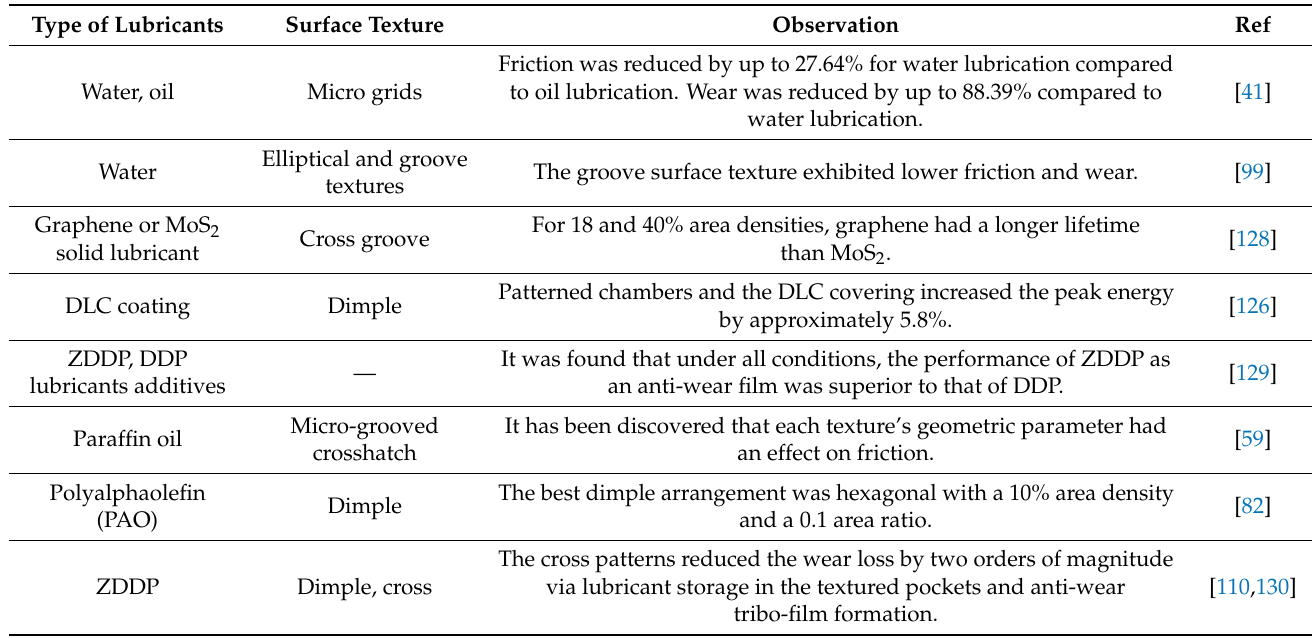
The groove surface texture exhibited lower friction and